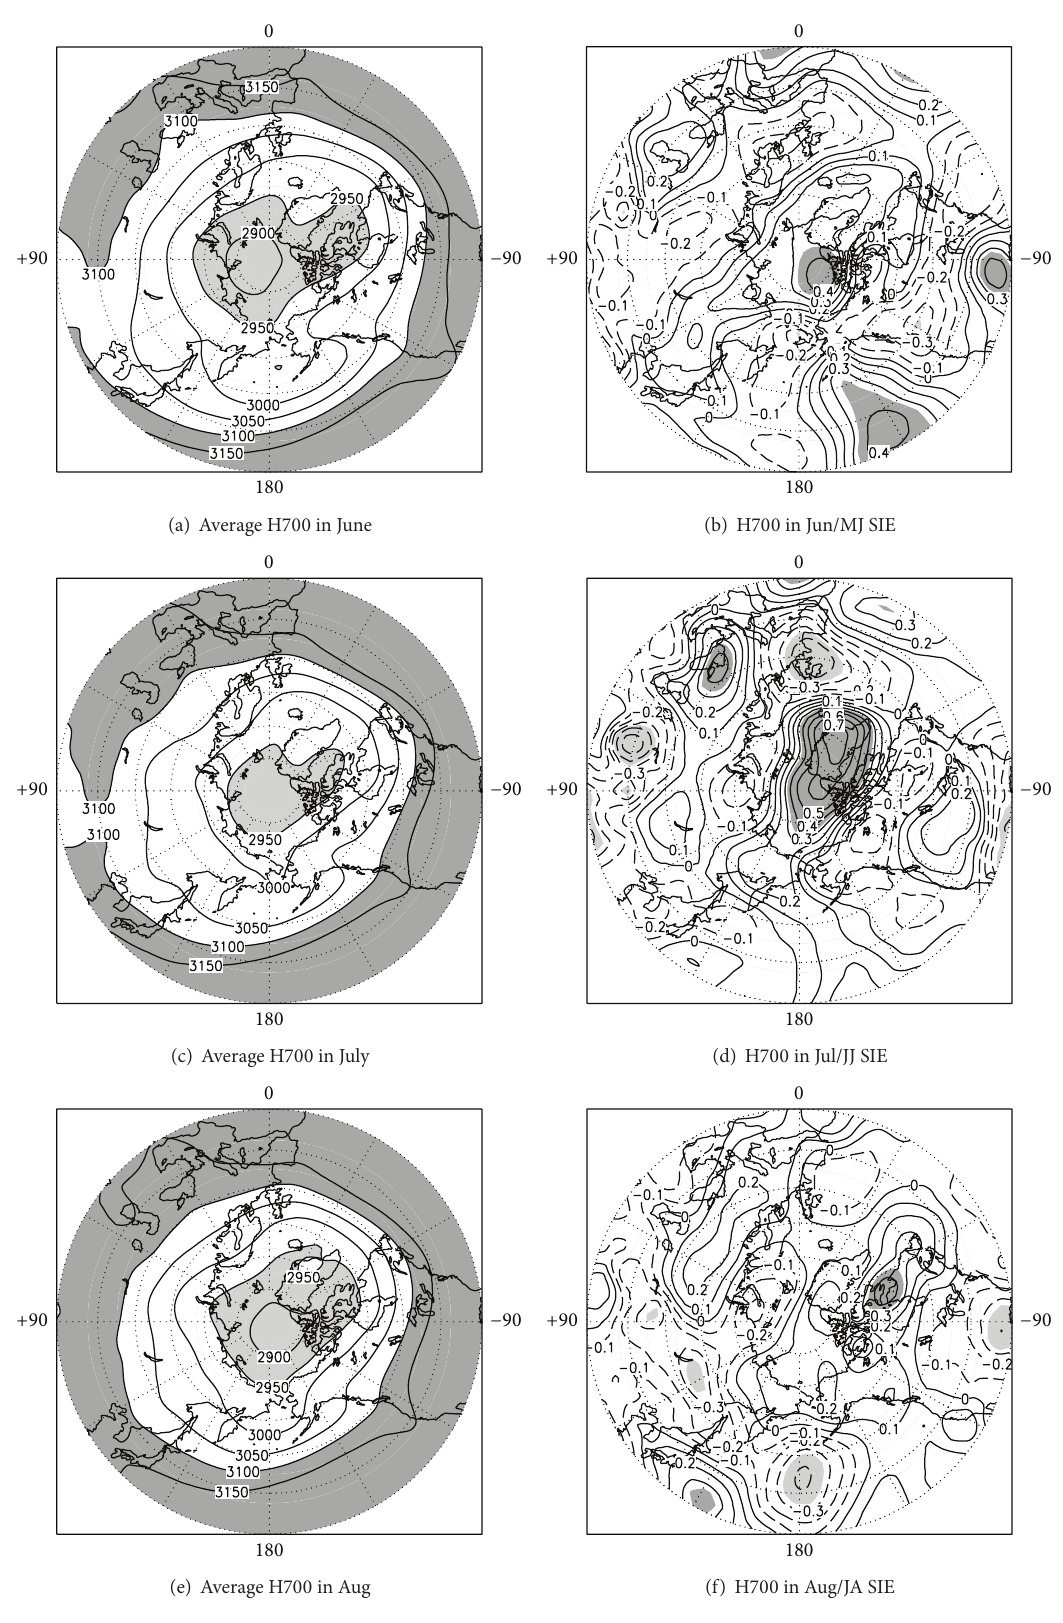
Figure 4: As in Figure 3 but for monthly 700 hPa